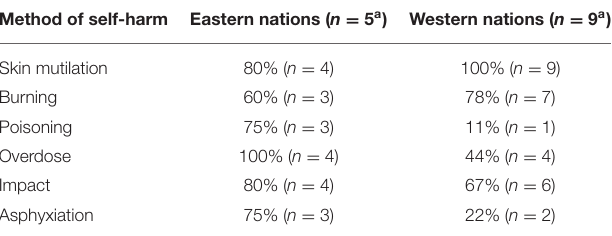
TABLE 6 | Comparison of methods of self-harm between Eastern and Western